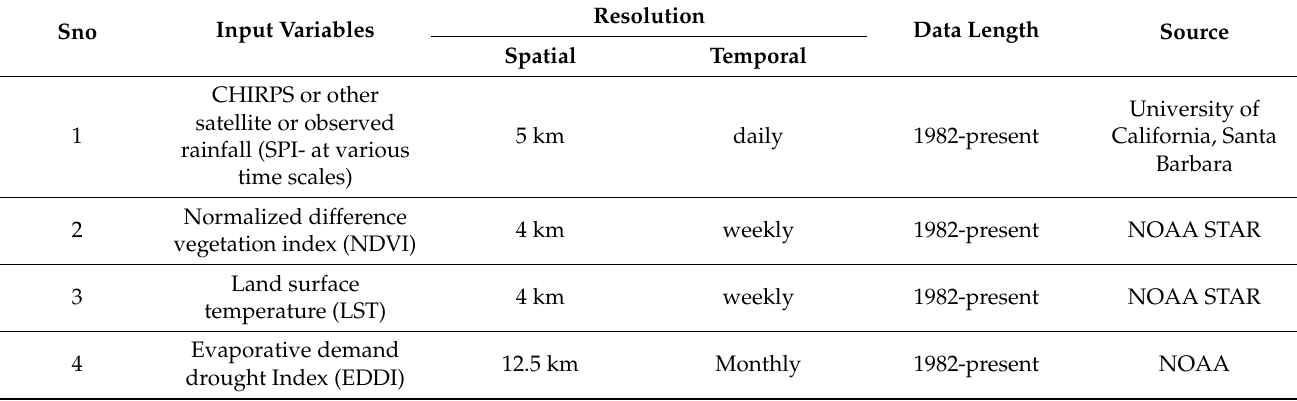
Table 1. Input variables used to monitor agricultural and water supply droughts and their spatial and temporal resolutions.